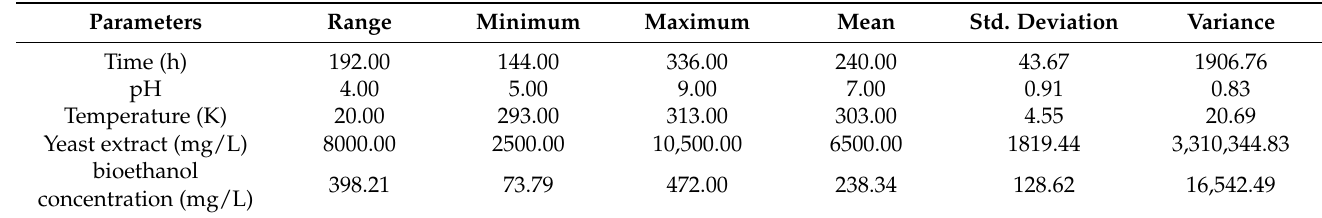
Table 2. Descriptive statistics of the predictors and the